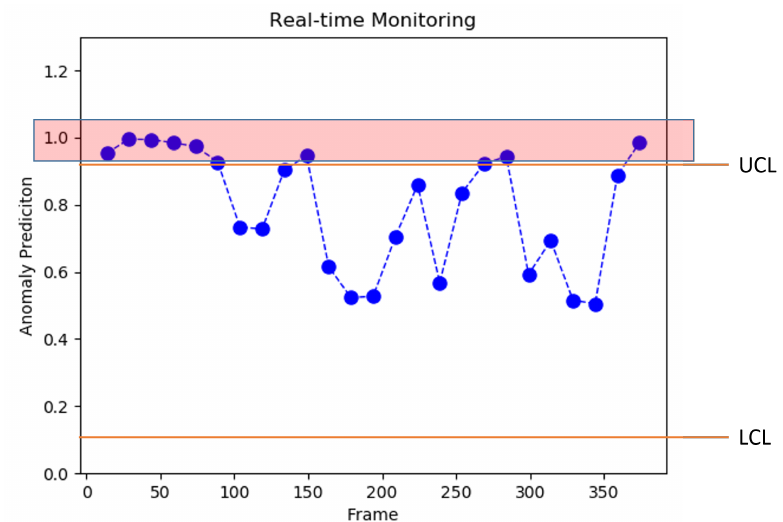
Figure 2. The visual representation of control